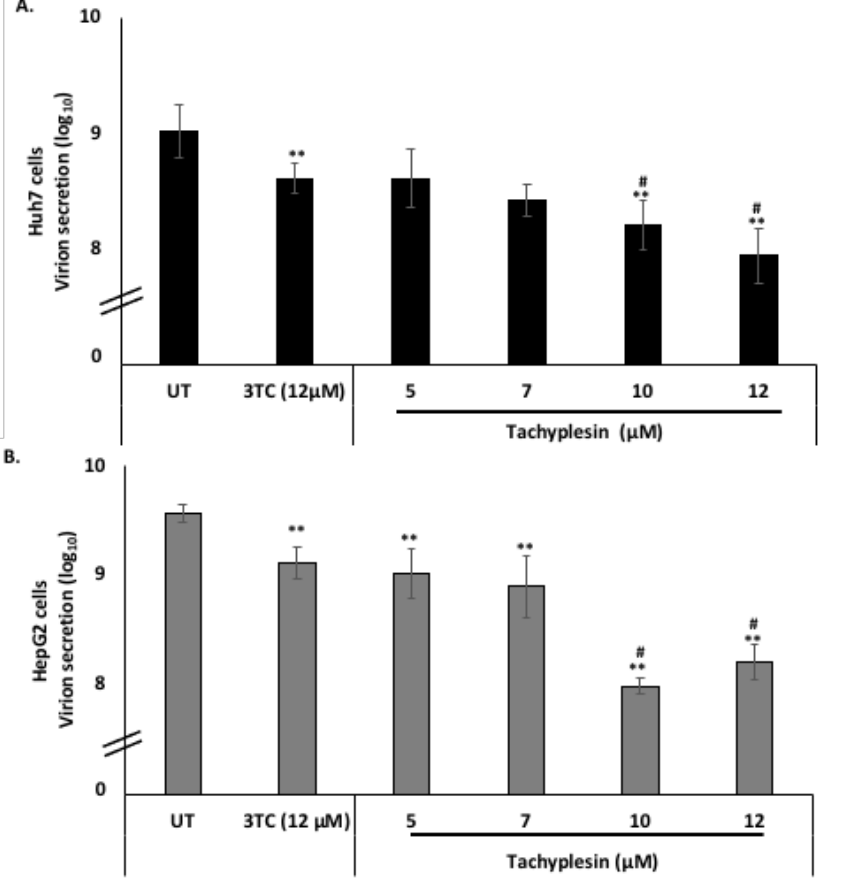
Figure 6. Tpl inhibits hepatitis B virus virion secretion in Huh7 cells and HepG2 cells. Tpl inhibited virion secretion in a concentration-dependent manner in both ( A ) Huh7 and ( B ) HepG2 cell lines. ** represents significant difference with respect to untreated ( p -value < 0.01, Student’s t -test). # represents significant difference with respect to 3TC ( p -value < 0.05). UT = Untreated, 3TC = lamivudine.